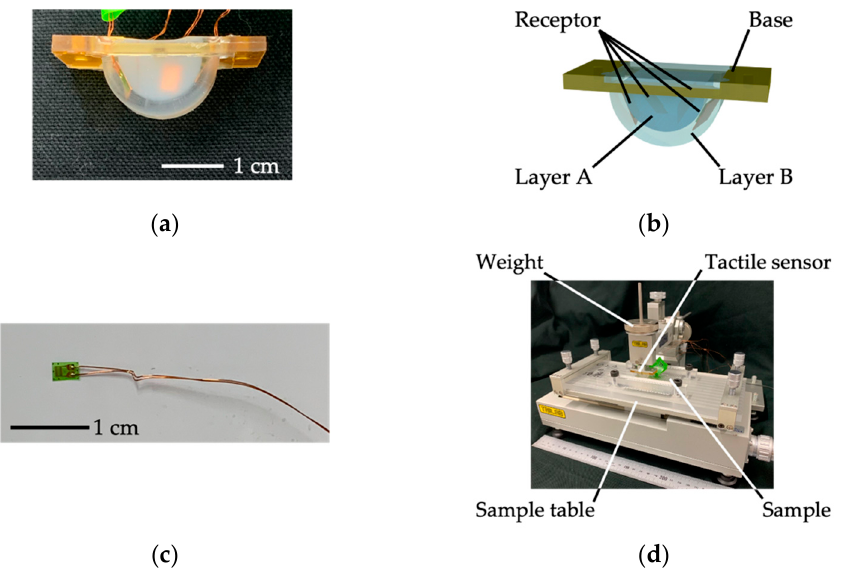
Figure 3. Tactile sensing system with the developed tactile sensor: ( a ) photograph of the fabricated tactile sensor, ( b ) overview of the tactile sensor, ( c ) photograph of the strain gauge, and ( d ) overall view of the sensing system. The image in ( d ) shows the tactile sensor running over a sample as a result of the sliding of the sample table.